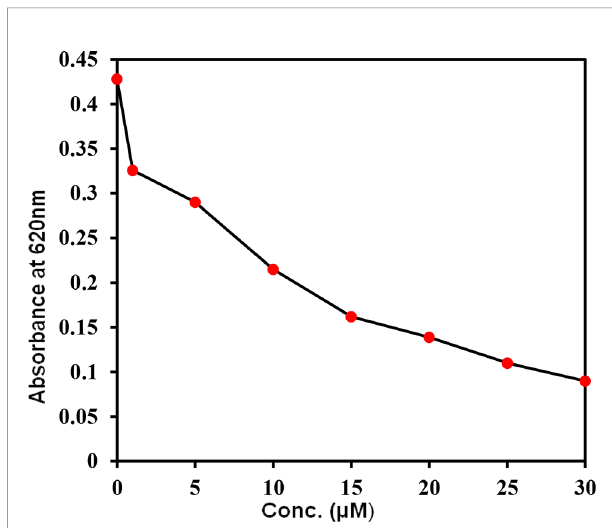
FIGURE 8 | Kinase activity of CDK6 with increasing concentrations of selonsertib. The kinase activity of CDK6 was measured in the form of ATP release (ATPase activity).